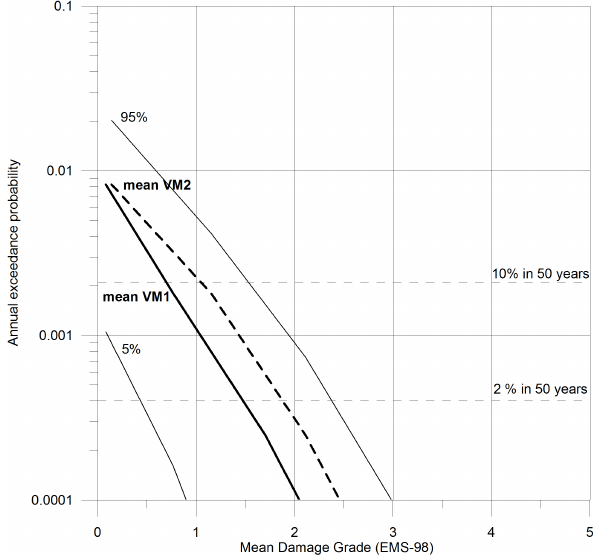
Figure 8. Structural damage probability estimation (in terms of mean damage grade) for the residential building stock of Cologne. The solid line corresponds to the mean estimate for VM1, the dashed line for VM2. The uncertainty bounds (5 and 95%) correspond to the total uncertainty.